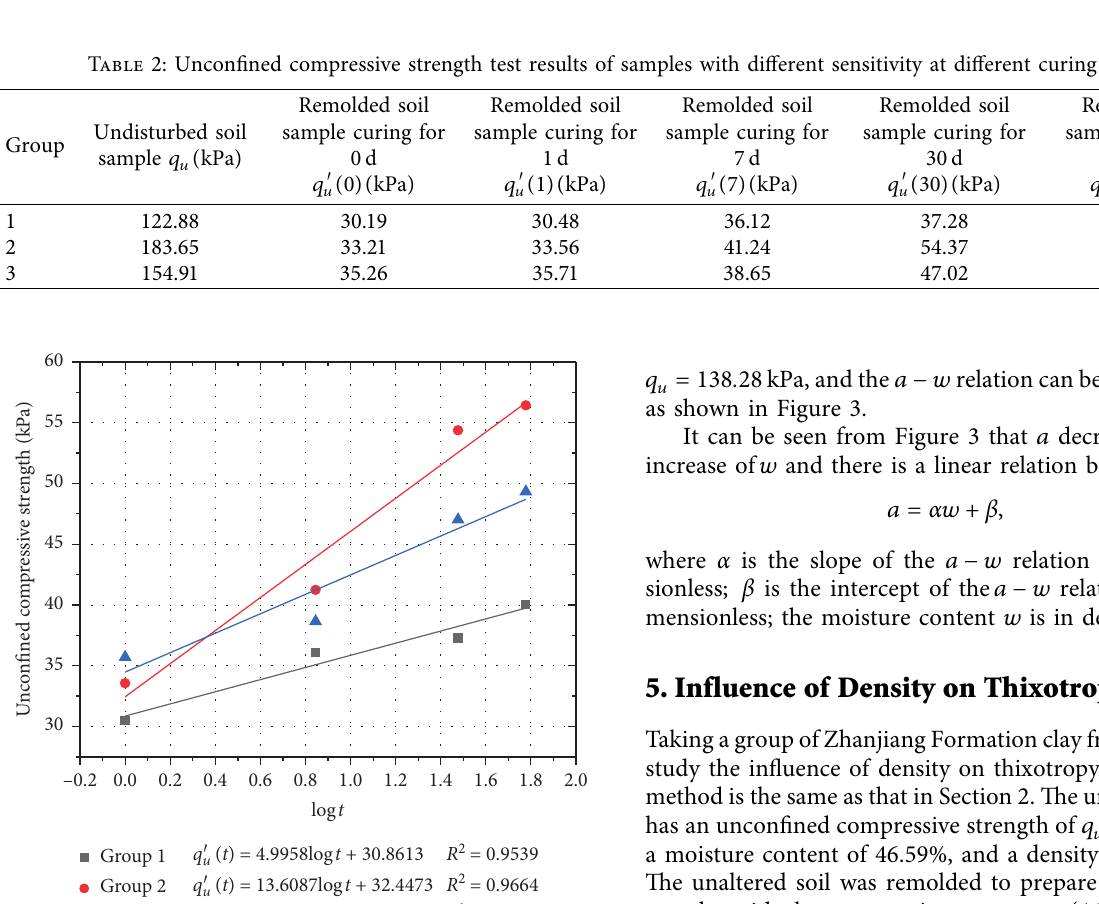
( t ) − log t relation curve of samples with different u ′